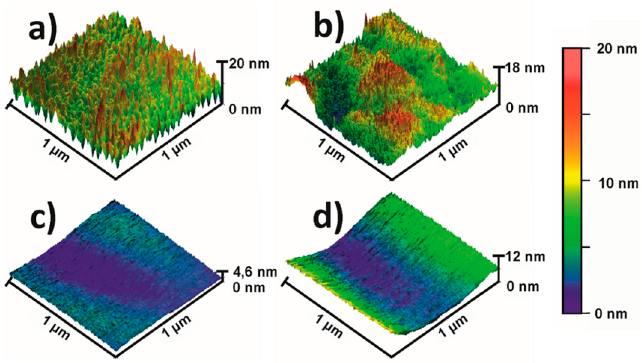
Figure 1. Representative atomic force microscopy (AFM) images of the uncoated ( a ) and coated ( b ) NiTi plates and the uncoated ( c ) and coated ( d ) CoCr plates.